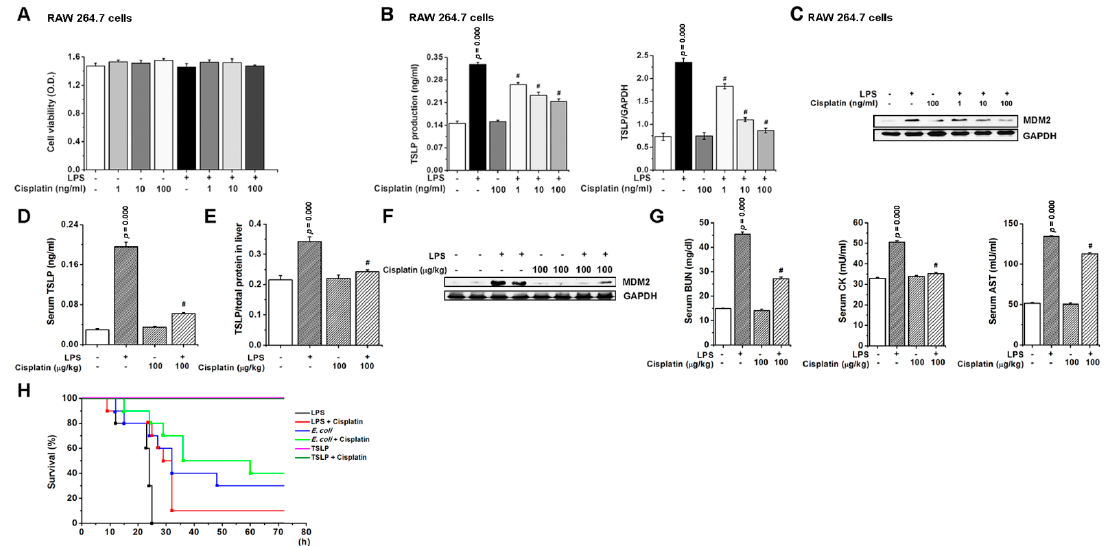
Figure 6. Pharmacological inhibition of TSLP by cisplatin protects mice against lethal sepsis. ( A ) RAW 264.7 cells were treated with cisplatin for 2 h, followed by incubation for 24 h with LPS (0.1 µ g / mL). Cell viability was analyzed by MTT assay. RAW 264.7 cells were treated with cisplatin for 2 h, followed by incubation for ( B , Left) 24 h with LPS (0.1 µ g / mL) for analysis of TSLP production and ( B , Right) for 8 h with LPS (0.1 µ g / mL) for analysis of TSLP mRNA expression. # p < 0.05 vs. LPS stimulation. ( C ) RAW 264.7 cells were treated with cisplatin for 2 h, followed by incubation for 8 h with LPS (0.1 µ g / mL). MDM2 expression in cells lysates was analyzed by Western blot. Each TSLP level in ( D ) serum at 4 h and ( E ) liver homogenate at 12 h following LPS (10 mg / kg) injection was analyzed by ELISA. Adducts were normalized to total protein in liver homogenate. ( F ) MDM2 expression in liver homogenate at 12 h following LPS (10 mg / kg) injection was analyzed by Western blot. For immunoblots, GAPDH was used as a loading control. ( G ) BUN, CK, and AST levels were analyzed in the serum at 4 h following LPS (10 mg / kg) injection ( n = 10 / group). PBS was treated as a vehicle negative control for cisplatin in LPS-unstimulated group. A p value indicates the significant di ff erence between PBS and LPS. # p < 0.05 vs. LPS stimulation. # p < 0.05 vs. LPS-injected mice. ( H ) Survival curve (%) was monitored in mice ( n = 10 / group) injected intraperitoneally with LPS (60 mg / kg), E. coli (1 × 10 8 CFU), or TSLP (2 µ g) following intravenous injection of cisplatin (100 µ g / kg). LPS, lipopolysaccharide; TSLP, thymic stromal lymphopoietin; MDM2, murine double minute 2; BUN, blood urea nitrogen; CK, creatine kinase; AST, aspartate aminotransferase.